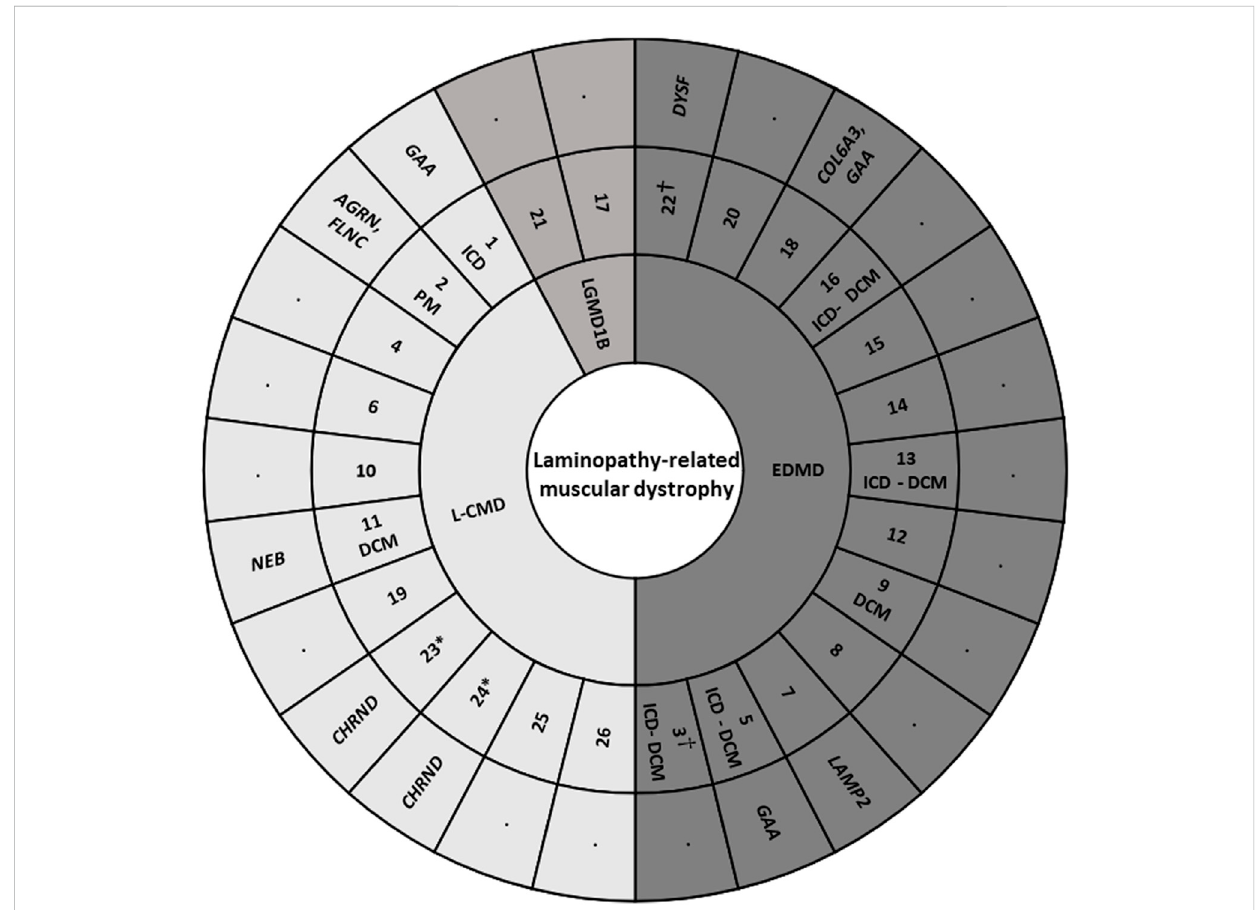
FIGURE 1 Cohort of index cases. DCM, dilated cardiomyopathy. EDMD, Emery-Dreifuss muscular dystrophy. ICD, implantable cardioverter de fi brillator. L-CMD, LMNA -related congenital muscular dystrophy. LGMD1B, Limb-girdle muscular dystrophy 1B. PM, pacemaker. *, twins. † , sudden